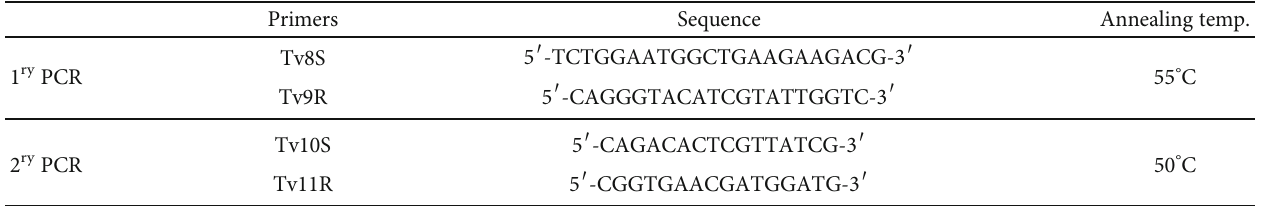
Table 1: The used primers ’